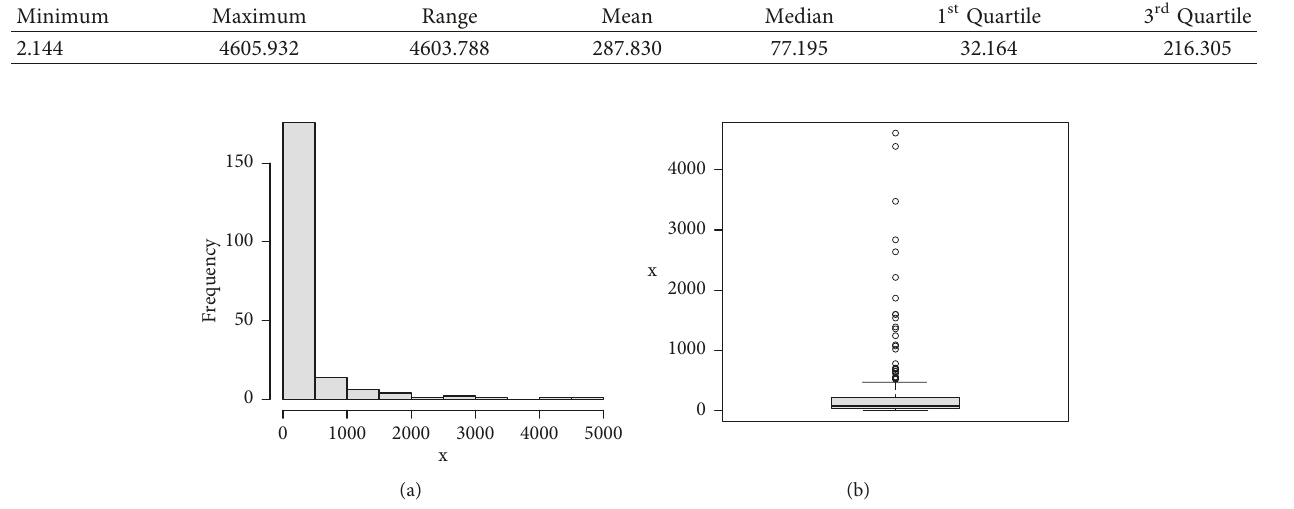
Table 5: Descriptive statistics of catastrophe data.